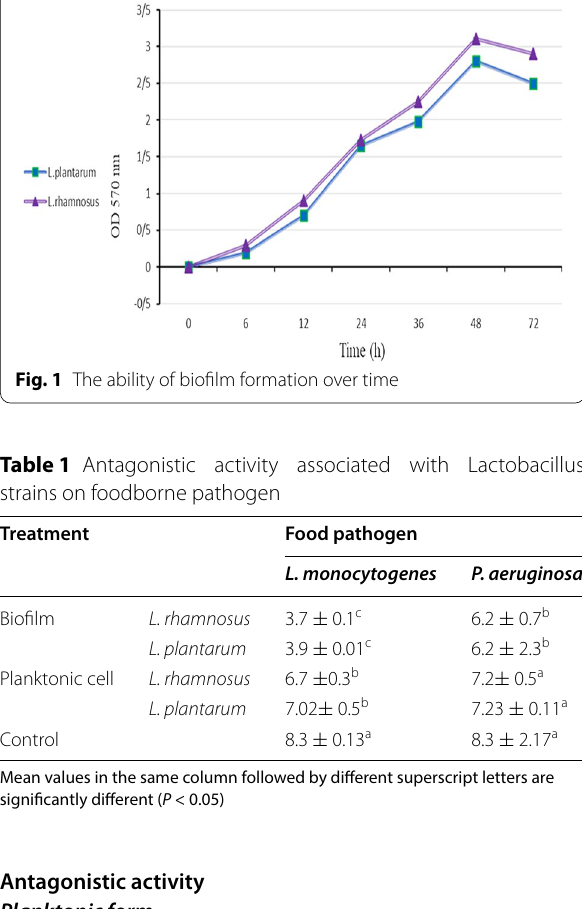
Mean values in the same column followed by different superscript letters are significantly different ( P < 0.05)